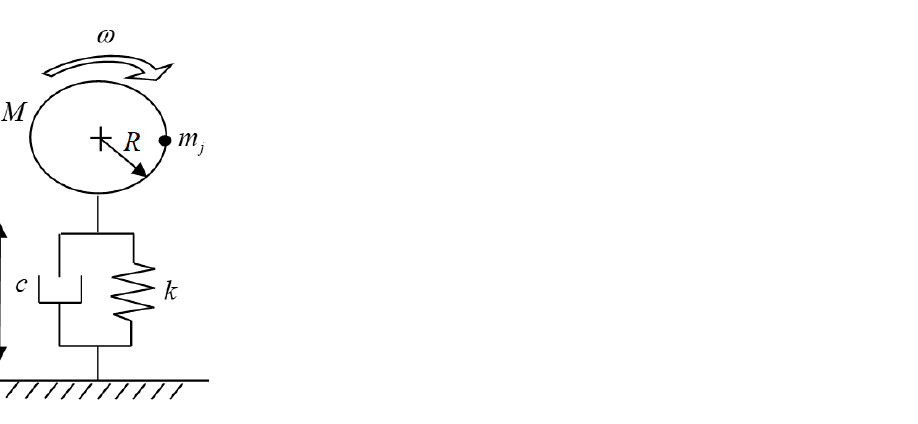
Figure 1. Simplified model of a 1-DOF system with a force due to imbalance.